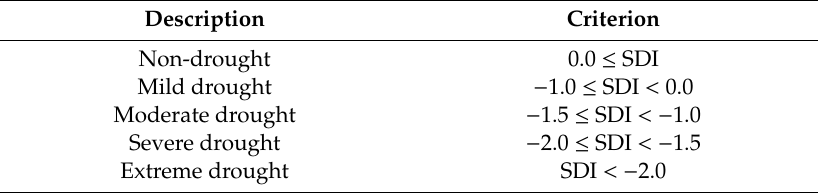
Table 2. Description of hydrological drought based on the streamflow drought index (SDI) criterion [13].